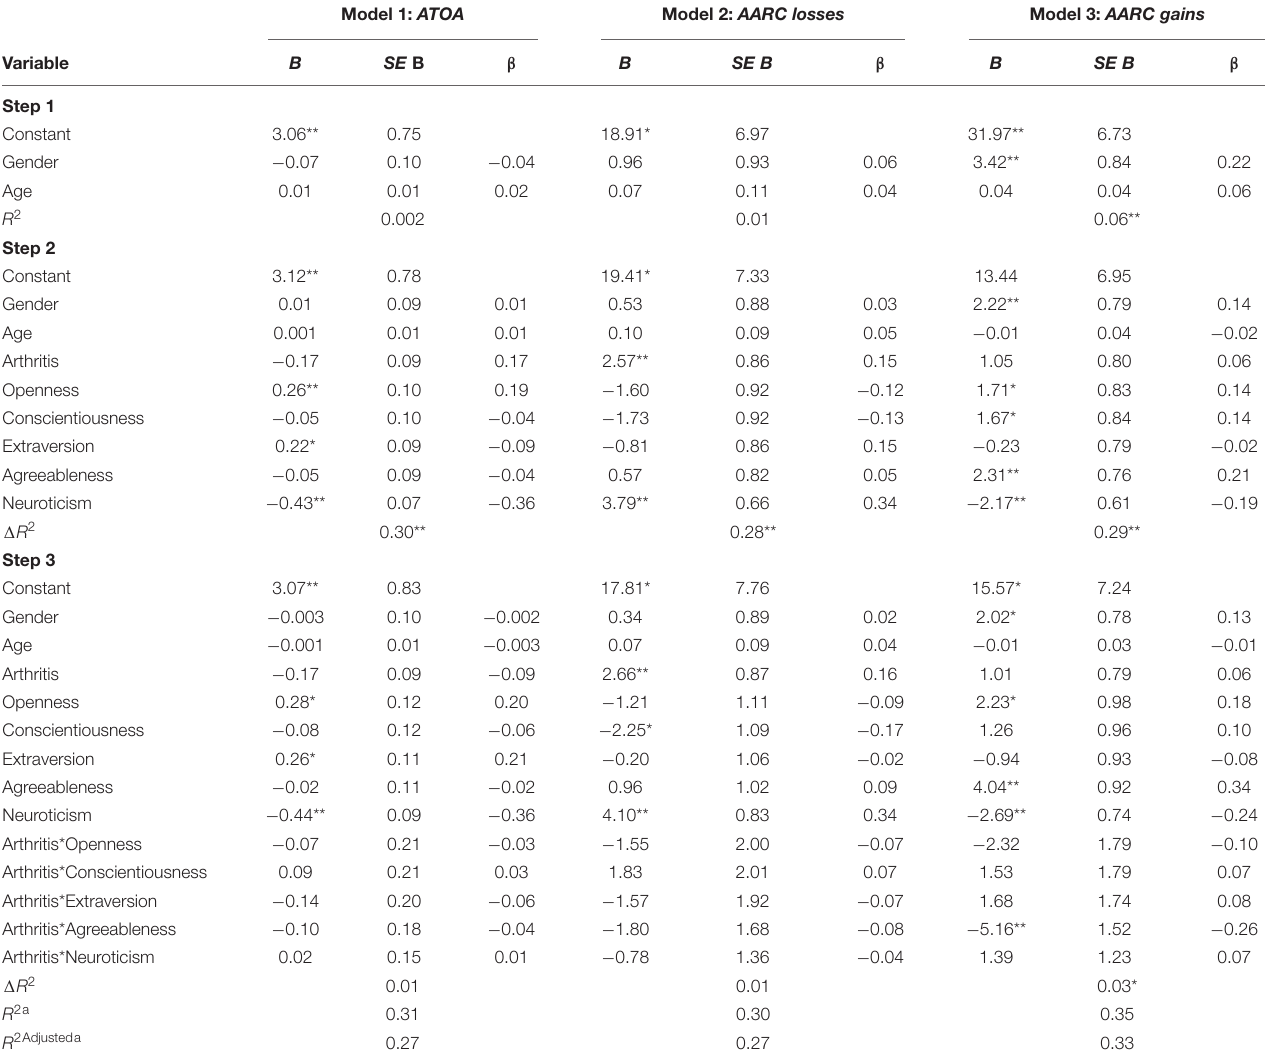
TABLE 2 | Hierarchical regression for ATOA, AARC losses, and AARC gains. Model 1: ATOA Model 2: AARC losses Model 3: AARC